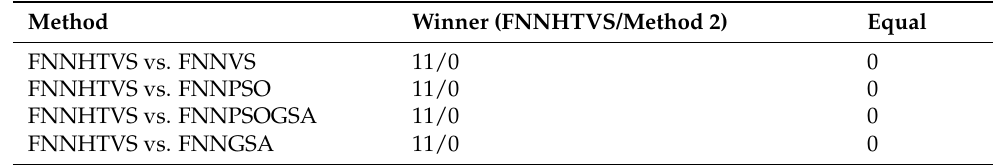
Table 7. WSR test results for the wine recognition problem.